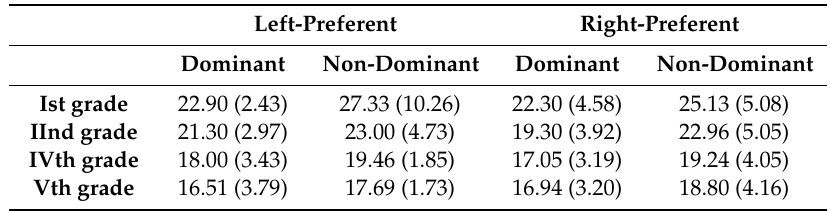
Table 2. Results of the Floppy test (time to completing) stratified by school grade and hand preference. Lower values denote better results.